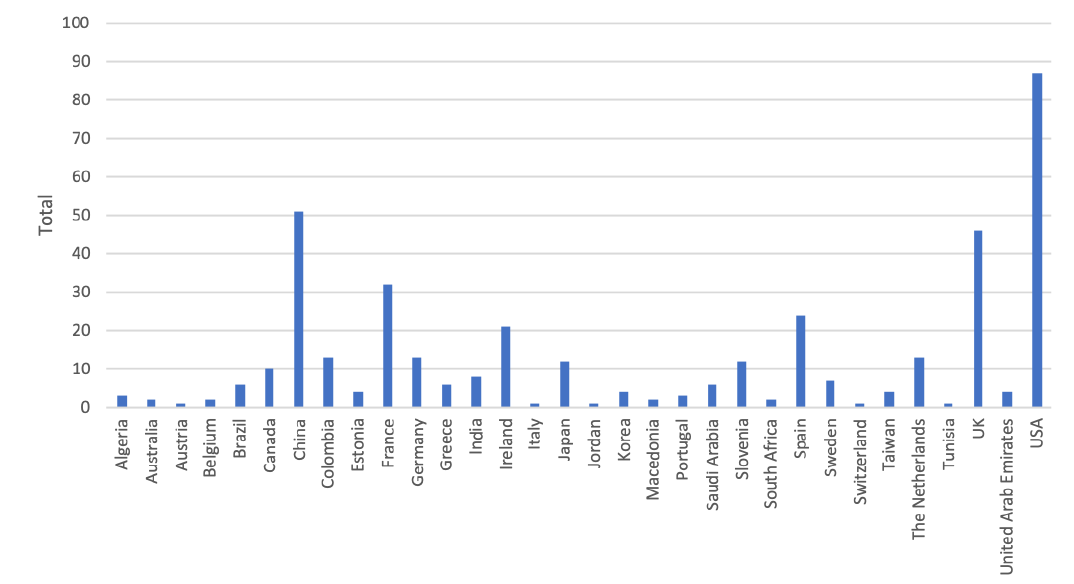
Figure 3. Number of authors affiliated in each country. Authors are calculated for each article, i.e., an author may be calculated more than once and in more than one country.